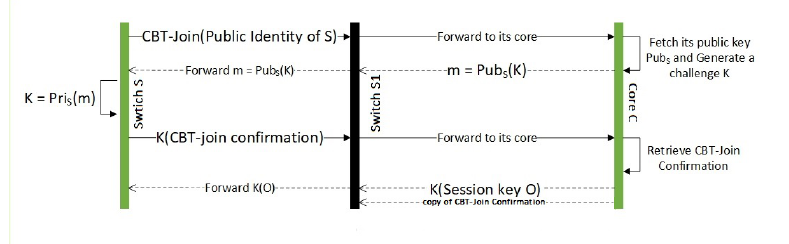
Figure 2. CBT-Join for switches that are more than one hop away from a core